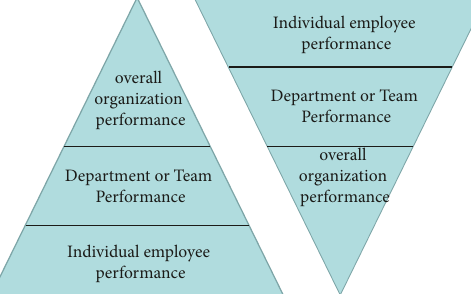
Figure 2: Three levels of organizational